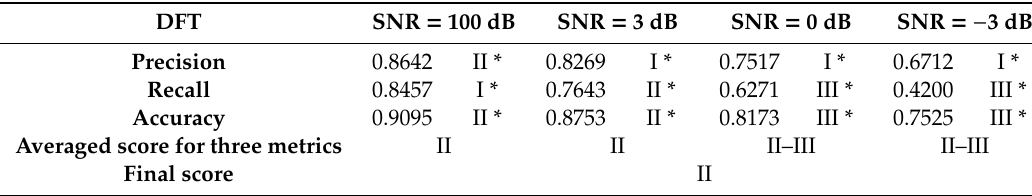
Table 16. Classification results: